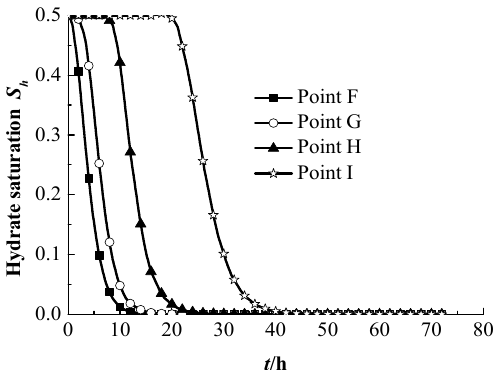
Figure 9. Curves of hydrate saturation with time at different positions.